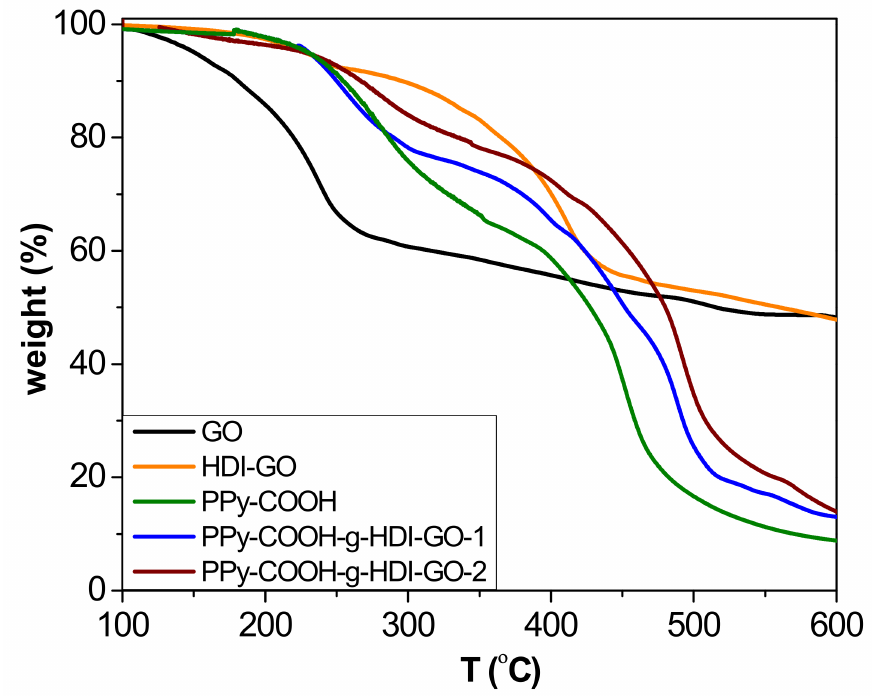
Figure 5. TGA curves under inert atmosphere of GO, HDI-GO, PPy-COOH, and the grafted